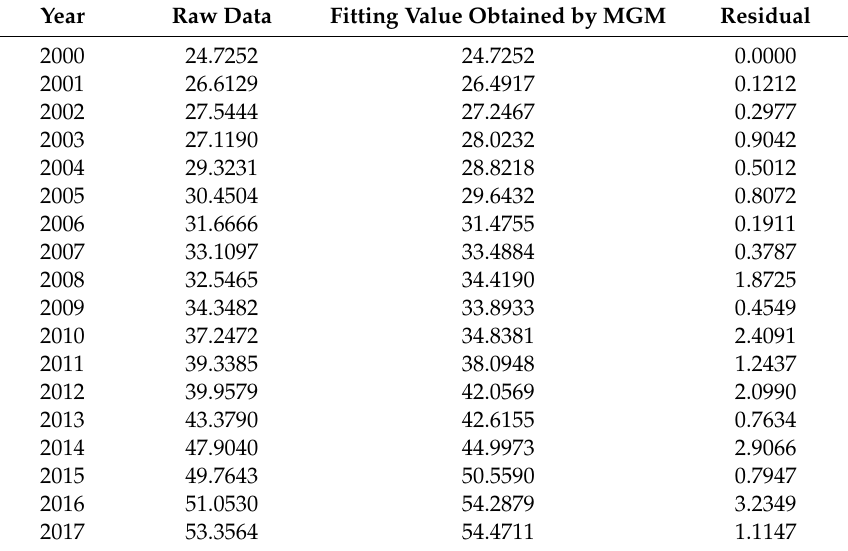
Table 7. Relative error based on MGM fitting.